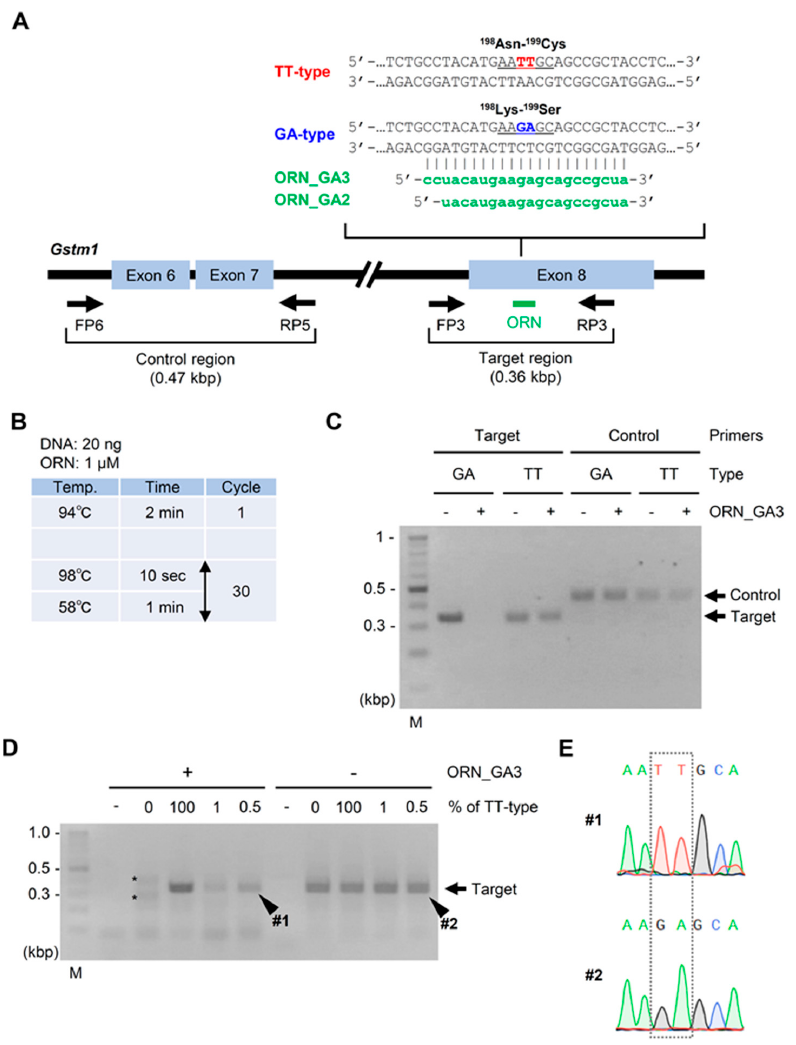
Figure 2. ORNi-PCR using DNA extracted from AFPE rat liver specimens to discriminate a polymorphism in the Gstm1 gene. ( A ) Positions of primers and ORNs targeting the GA-type allele of the rat Gstm1 gene. Arrows indicate forward and reverse primers for amplification of a target region (FP3 and RP3) and a control region (FP6 and RP5). ( B ) Experimental conditions for ORNi-PCR. ( C ) Results of ORNi-PCR. M—molecular weight marker. ( D ) Results of ORNi-PCR. ORNi-PCR with mixed DNA (0–100% of TT-type Gstm1 in total Gstm1 ) was performed as shown in ( B ) with 40 cycles of denaturation and annealing / elongation steps. In this experiment, 20 ng of AFPE DNA, including GA-type Gstm1 , was mixed with AFPE DNA, including TT-type Gstm1 , so that the TT-type Gstm1 accounted for 1 or 0.5% of the total Gstm1 . The mixed DNA was used for ORNi-PCR. * indicates non-specific amplicons. ( E ) Results of DNA sequencing analysis. ORNi-PCR (#1) and PCR (#2) amplicons shown in ( D ) were subjected to DNA sequencing analysis. Sequencing signals around the polymorphism are